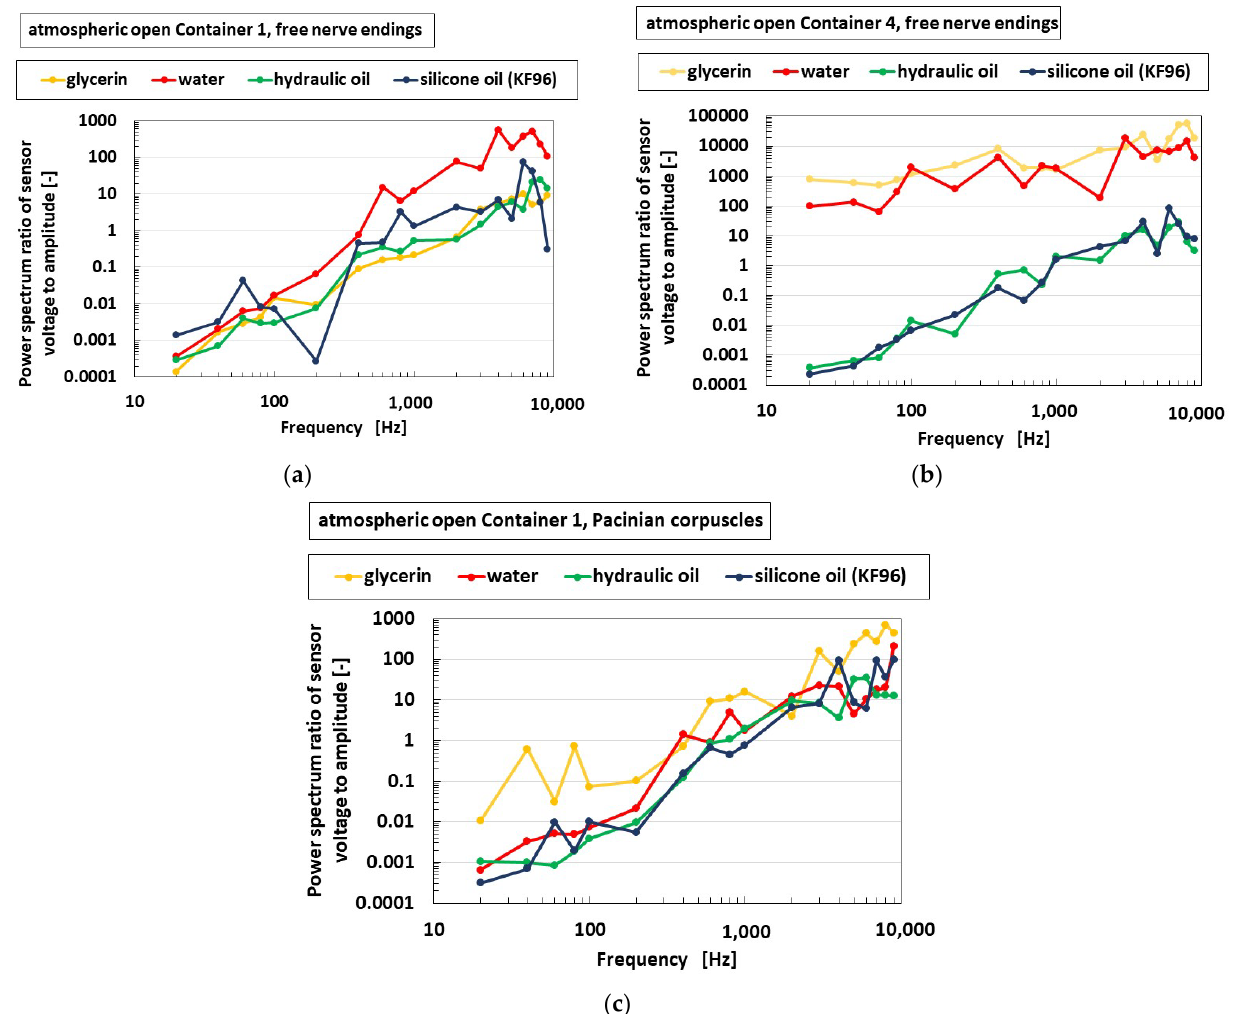
Figure 19. Experimental results of the vibrating auditory sensor with the vibration of a speaker when types of liquid are compared: ( a ) with free nerve endings in Container 1; ( b ) with free nerve endings in Container 4; ( c ) with Pacinian corpuscles.